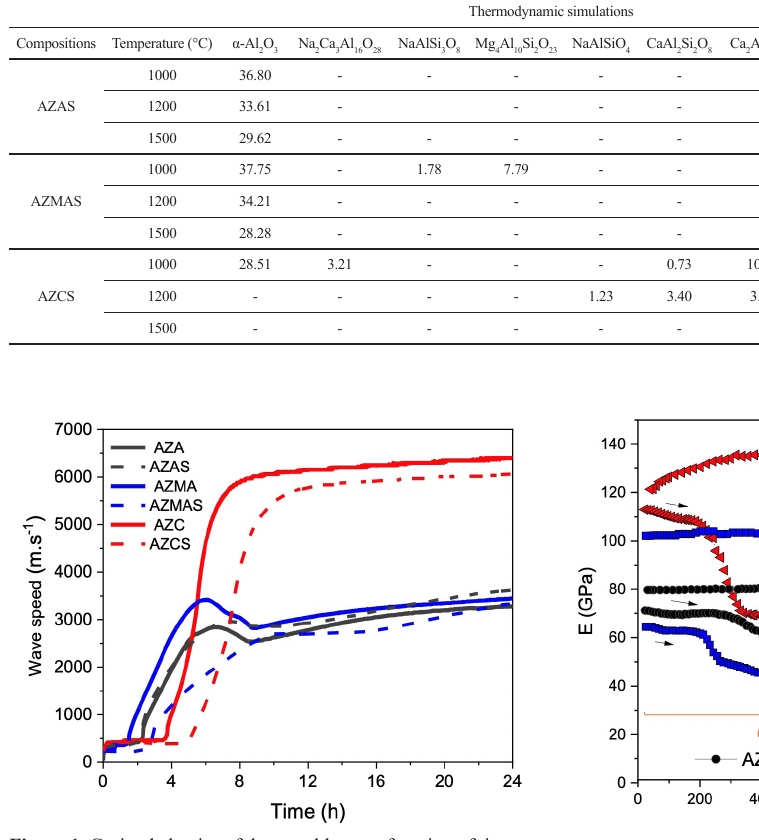
Figure 2. In situ hot elastic modulus of the designed castables containing ZnO and 1 wt% of silica fume (AZAS, AZCS and AZMAS). Samples were cured at 30 °C for 24 h and dried at 110 °C for another 24 h before testing.